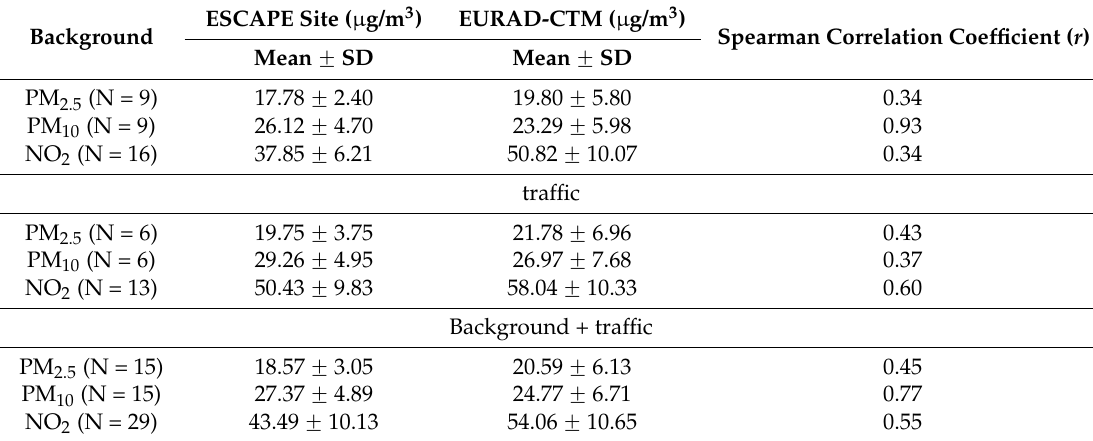
Table 3. Description of 14-day mean measured air pollution concentrations at ESCAPE measurement sites (background and/or traffic) and 14-day mean air pollution concentration estimations of EURAD-CTM in the corresponding grid cells for PM 2.5 , PM 10 , and NO 2 .